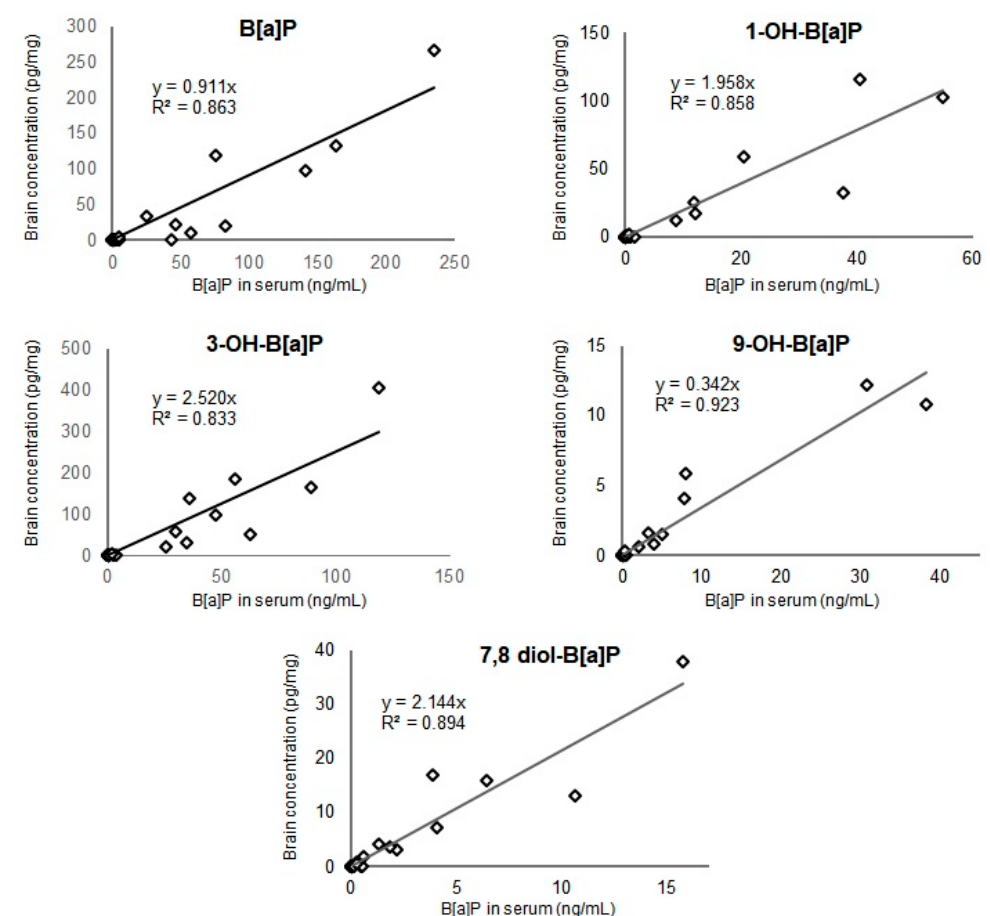
Figure 3. Linear relationship between the concentration levels of 7,8-diol-B[a]P, OH-B[a]P and B[a]P in serum and brain of mice exposed via oral administration using doses up to 200 mg/kg for 10 consecutive days ( n = 28, p < 0.001, Spearman analysis).